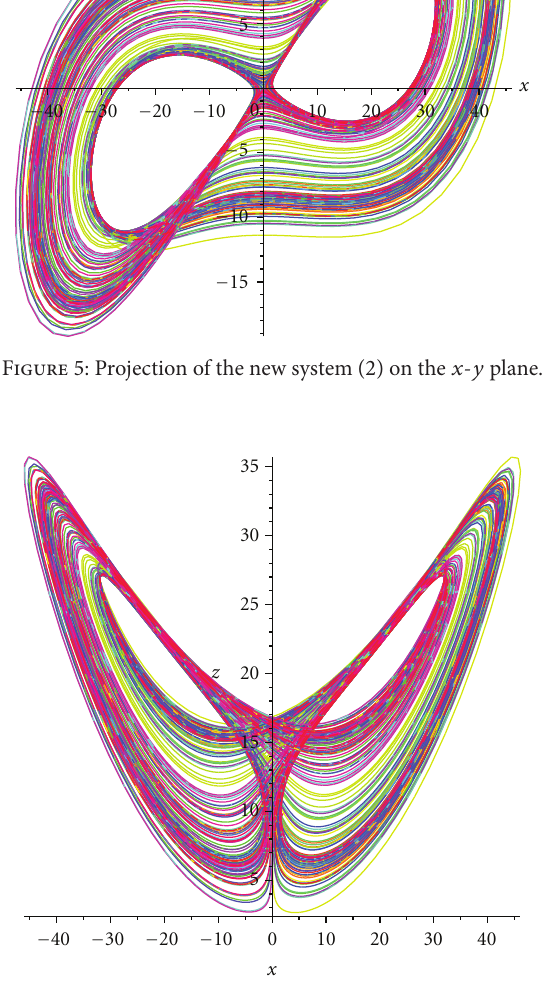
F 6: Projection of the new system (2) on the